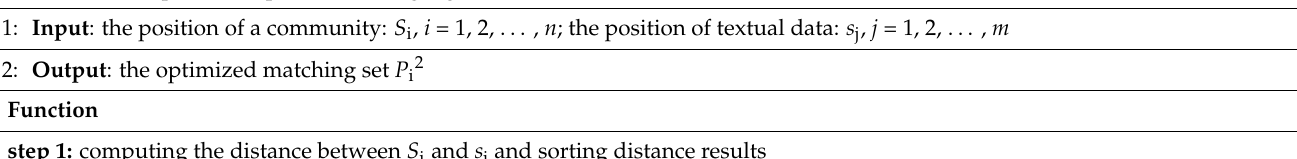
Algorithm 1. Optimized spatial matching algorithm